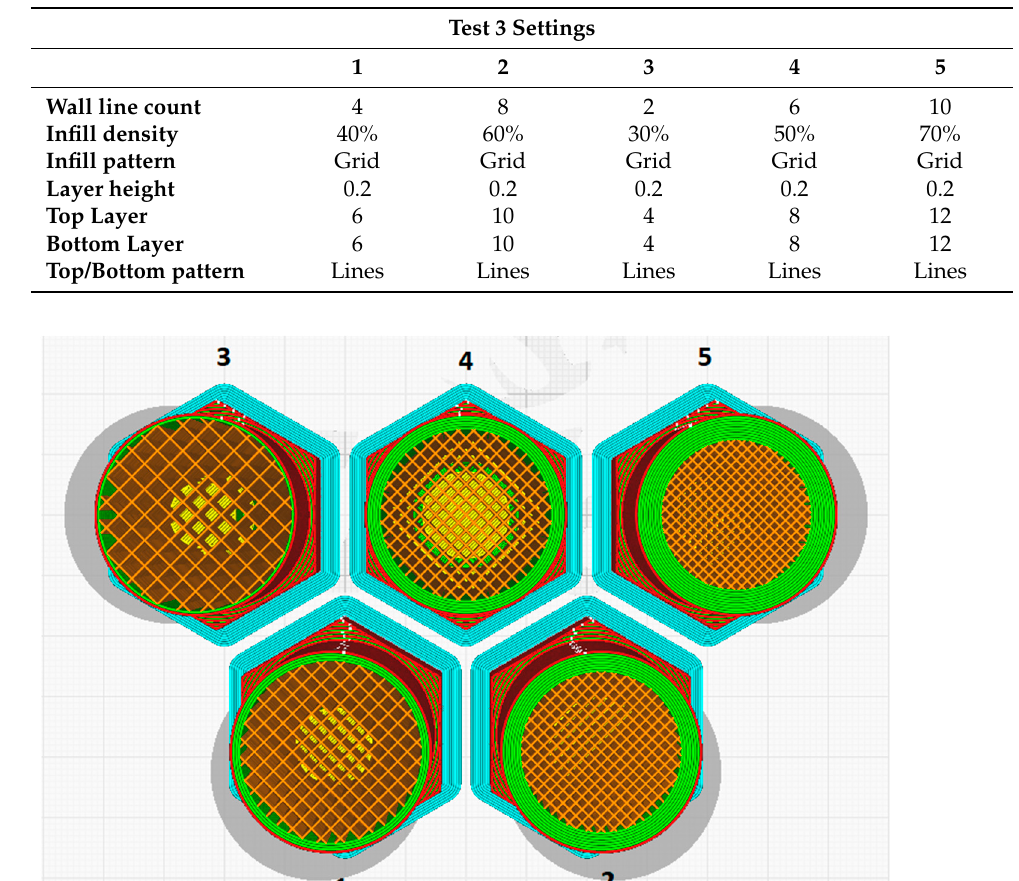
Figure 6. Punch settings of Test 2. Table 7. Punch settings of Test 3.